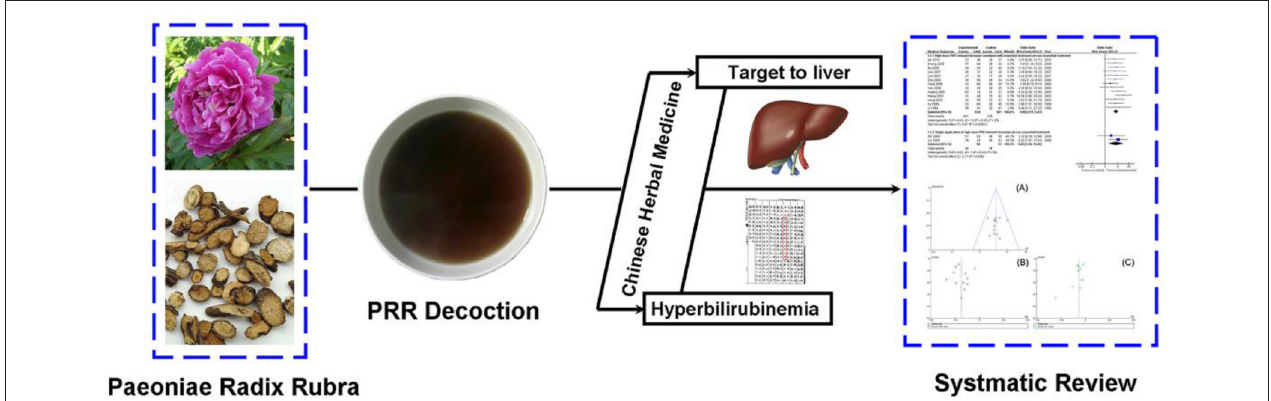
FIGURE 1 | Study flow of Paeoniae Radix Rubra in hyperbilirubinemia. It demonstrated that PRR has been used for the treatment of blood stasis for hundreds of years, as evidenced by records from Ben Cao Gang Mu in 1578 (Ming dynasty). This study was performed to assess the clinical value of high-dose PRR-relevant formulae in the treatment of